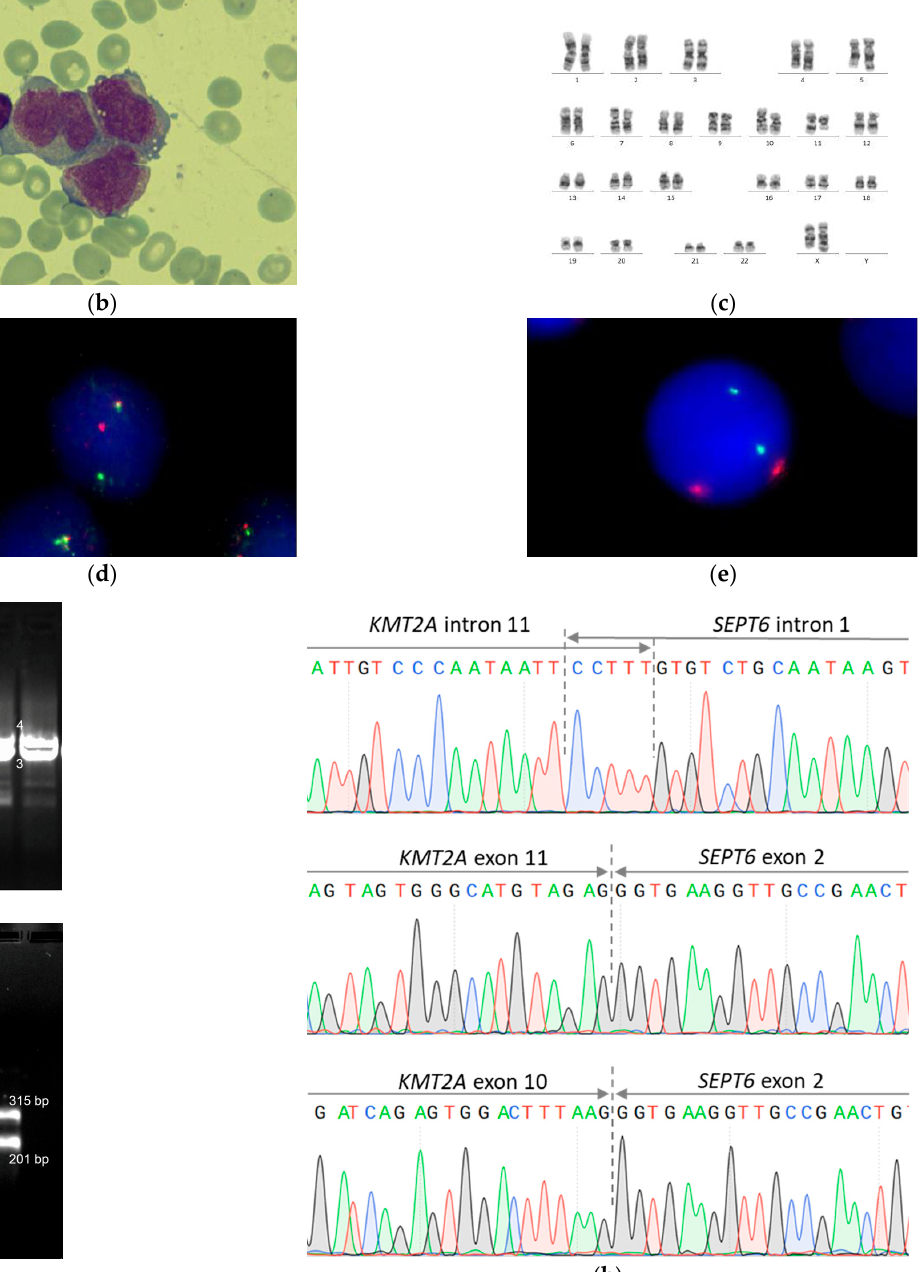
Figure 2. RARA -negative KMT2A -positive AML patient analysis: ( a ) BM cells immunophenotyping (surface and intracellular (“i”) expression of characteristic markers by flow cytometry; on the dot plots, tumor cells are red while remaining BM cells are gray); ( b ) blasts with APL-like morphology as depicted by Pappenheim–Kryukov staining in BM smear; ( c ) GTG-banded karyotyping showing ins(X;11)(q24;q14q25); ( d ) FISH with Kreatech ON KMT2A break-apart probe; ( e ) FISH with Kreatech ON t(15;17) PML::RARA dual-color dual-fusion probe; ( f ) KMT2A LDI-PCR on BM DNA (2 and 4 are wild-type bands, 1 and 3 are rearranged bands); ( g ) RT-PCR on BM RNA (315 bp band